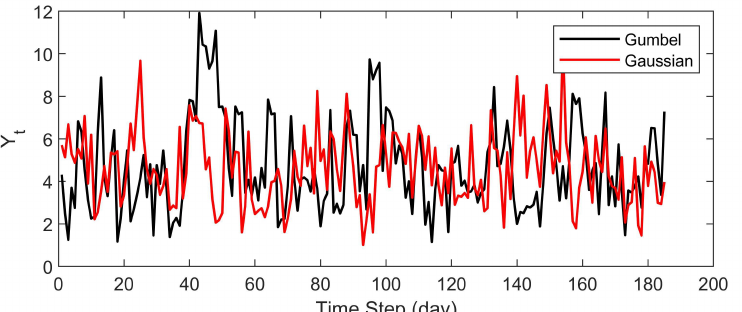
Figure 9. Evaporation { Y t } time series generated by Gumbel and Gaussian